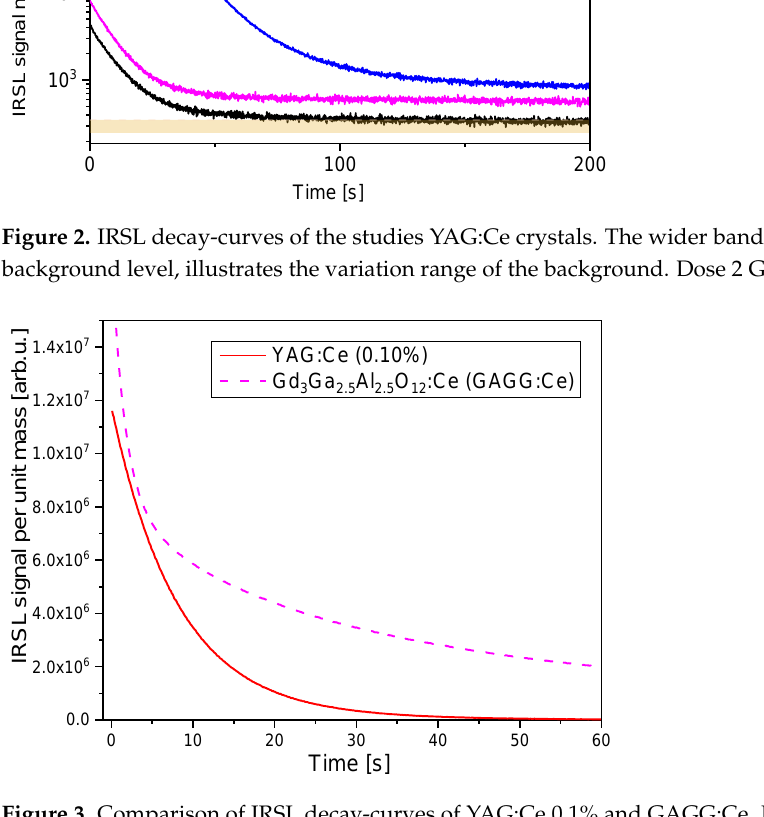
Figure 3. Comparison of IRSL decay-curves of YAG:Ce 0.1% and GAGG:Ce. Dose 2 Gy. The OSL signal measured under constant stimulation can be described by an expo- nential function of time (assuming first-order kinetics). However, usually, the shape of a decay curve cannot be correctly described by just a single exponent, but rather a sum of exponential functions must be used. Figure 4 presents the results of the analysis of the decay curves registered during 1000 s of IR stimulation. To obtain a satisfactory fit, three exponential components were needed for the crystal with 0.1% of Ce and two components for the remaining samples. In all samples, the dominant is a fast-decaying component with a time constant of around 9 s. The IRSL curves of Ce-doped samples also contain a very slowly decaying component (time-constant > 1000 s). For the crystal with 0.1% Ce, the presence of a medium component (time constant 90 s) is also evident.